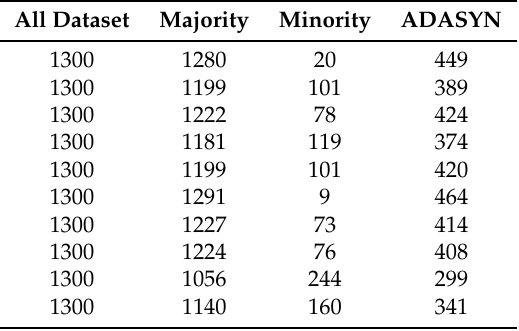
Figure 12. The evaluation result of the ADASYN algorithm for different values of the coefficient β . Table 4. Number of synthetic new samples generated by the ADASYN algorithm ( β =